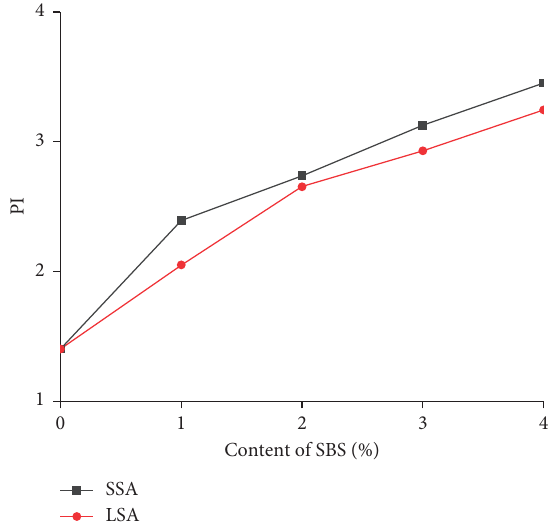
Figure 4: Variation of penetration index (PI) with the SBS contents for modified asphalts.